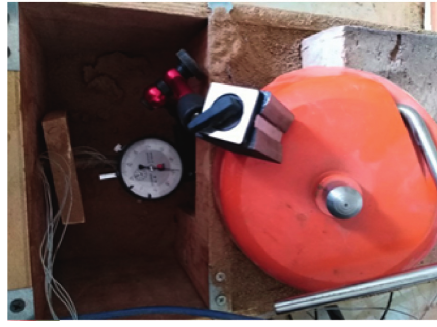
Figure 11: Installation of dial indicator for model test.